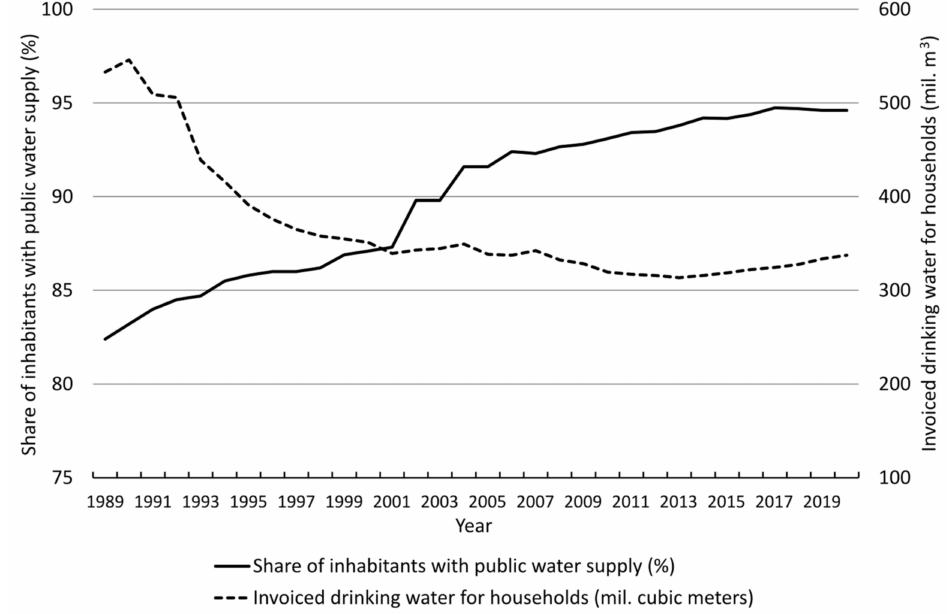
Figure 2. Development of the supply for inhabitants and the production of drinking water in the Czech Republic from 1989 to 2020. Data source: Czech Statistical Office